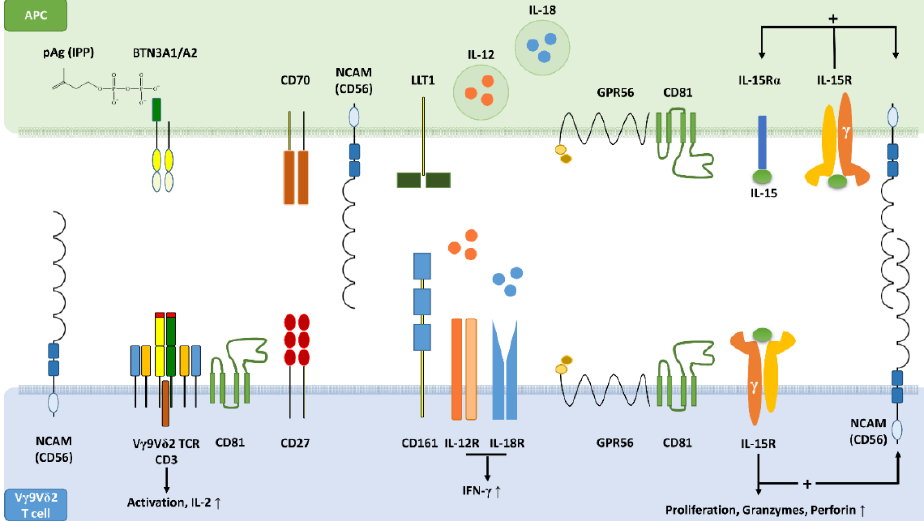
Figure 1. The concept of an innate-like immunological synapse. Schematic profile view showing key synaptic binding partners and signalling molecules that are involved in the activation of V γ 9V δ 2 T cells by antigen-presenting cells (APCs). Upon intracellular accumulation, pAgs such as isopentenyl pyrophosphate (IPP) bind to the B30.2 domain of butyrophilin (BTN)3A1 causing a conformational change of BTN3A1, which forms heterodimers with BTN3A2. Cognate interaction of V γ 9V δ 2 T cell receptors (TCRs) with BTN3A1/A2 initiates V γ 9V δ 2 T cell activation supported by CD70-CD27